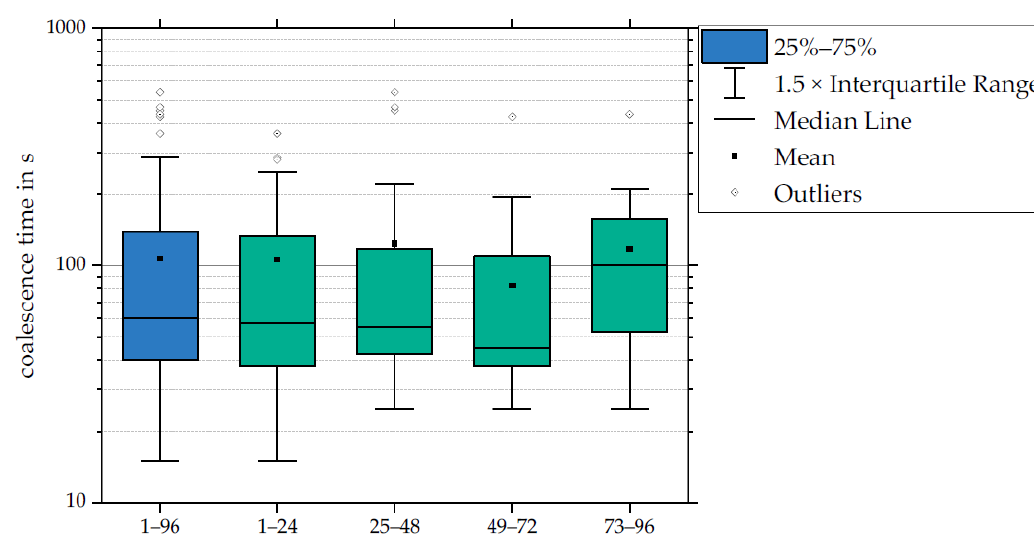
Figure 3. Data points from Figure 2 in a boxplot chart. The first boxplot shows the distribution of the complete measurement data set. The following four boxplots each show a quarter of the data. Since the variation between the four quarters is small, a 24-fold determination of each surfactant combination was deemed